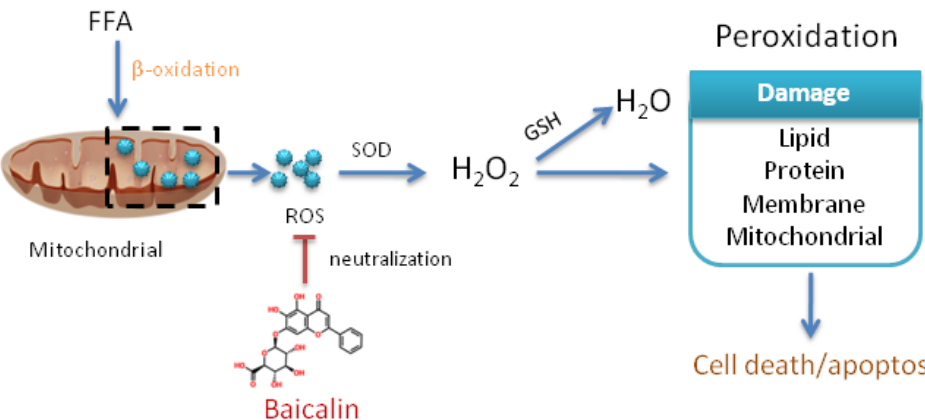
Figure 7. Summary of baicalin attenuating FFA-induced oxidative stress by scavenging reactive oxygen species. β -oxidation is the major oxidative pathway for fatty acids and a major source of ROS in mitochondria. ROS is converted to H 2 O 2 under the action of SOD, and then H 2 O 2 is decomposed into non-toxic H 2 O under the action of GSH. A lot of FFA leads to the imbalance between oxidation and antioxidation, producing excessive H 2 O 2 , which can cause damage to fat, protein, cell membrane and mitochondria, finally leading to cell death or apoptosis. Baicalin directly neutralizes ROS and reduces cell damage from oxidative stress, finally decreasing cell